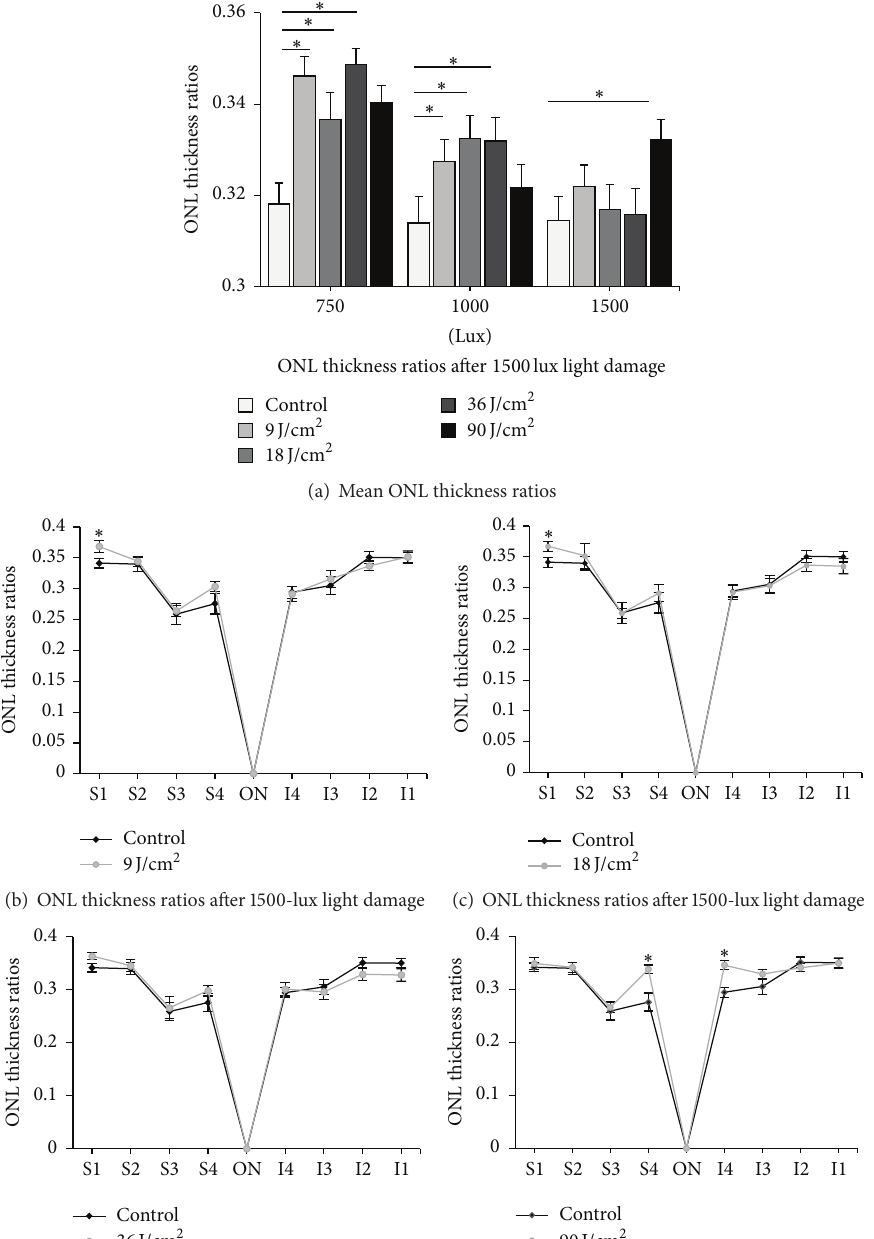
Figure 3: Effect of 670 nm light treatment on ONL thickness ratios. (a) Histograms showing mean ONL :retinal thickness ratios for three light damage protocols (750 lux/“low” intensity; 1000 lux/“moderate” intensity; 1500 lux/“high” intensity), summarizing the effects of four different treatment protocols. Following “low level” light (750 lux) damage ONL thickness is greater in the 670 nm light treated animals compared to controls (light damage only). Following “moderate” intensity (1000 lux) light damage, 9, 18, and 36 J/cm 2 670nm pretreated eyes have a significantly thicker ONL compared to controls, while those treated with 90J/cm 2 are not significantly different from untreated controls. Following “high” intensity light damage only treatment with 670 nm light at 90 J/cm 2 preserves ONL thickness. ((b) and (c)) Retinal thickness ratios in animals treated with 9 or 18 J/cm 2 670 nm light are similar to controls, except at the superior edge (sample S1). (d) Retinal thickness ratios in animals treated with 36 J/cm 2 670 nm light demonstrated no significant differences from controls. (e) Retinal thickness ratios in animals treated with 90 J/cm 2 670 nm light were significantly greater in the region surrounding the optic nerve head (S4 and I4) compared with controls ( 𝑛 = 6 animals for control and 9 J/cm 2 ; 𝑛 = 5 animals for 18J/cm 2 ; 𝑛 = 4 for 36J/cm 2 and 90J/cm 2 groups; “ ∗ ” denotes significance 𝑃 < 0.05 ; error bars represent SEM). ON: optic